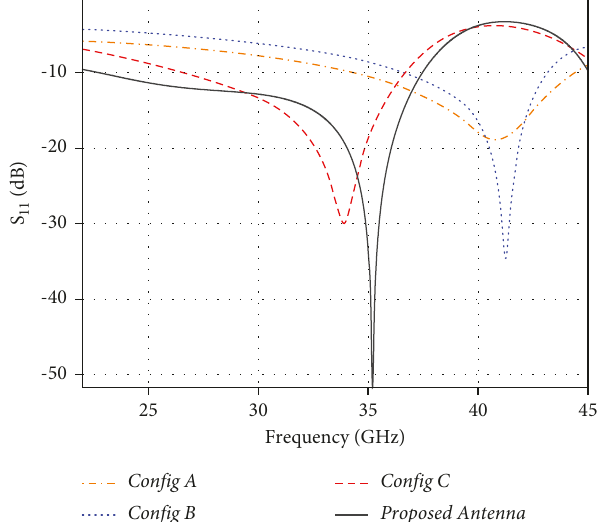
Figure 4: Simulated return loss parameters of the several con- figurations given in Figure 2.